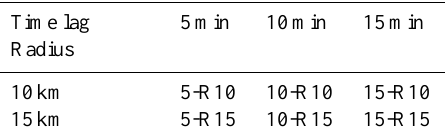
Table 1. The six schemes resulting from the various combinations of radius and time lags used in the present analysis.